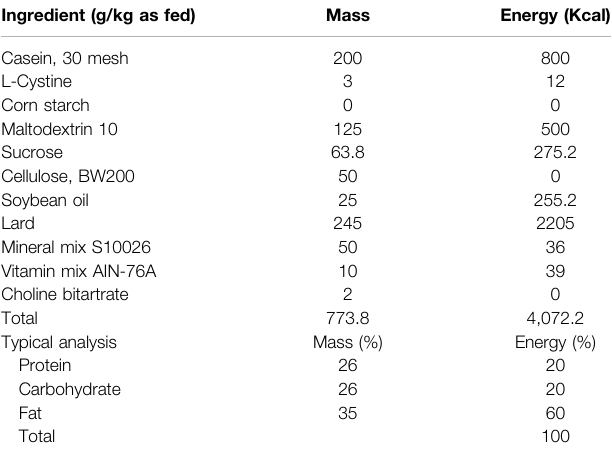
TABLE 1 | Composition and nutrient levels of high-fat diet (GD60 Rodent Diet). Ingredient (g/kg as